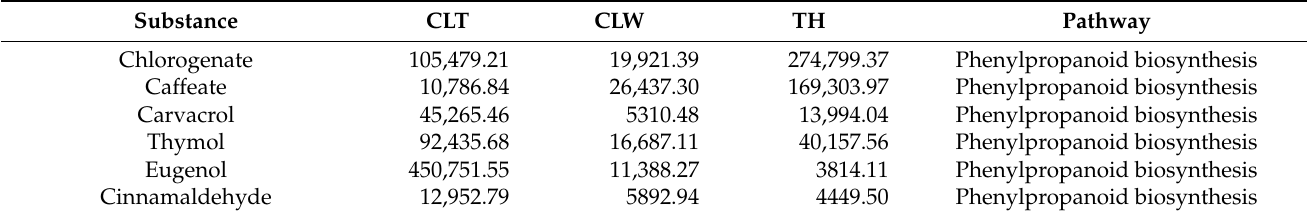
Figure 2. CLT, CLW, and TH group aroma substances expression heatmap. The top right corner is the highest to lowest expression, and red is the highest expression color. Note: The abbreviation of CLT, CLW, and TH was same with Figure 1. Table 1. Aromatic compound expression (relative units) in CLT, CLW, and TH.